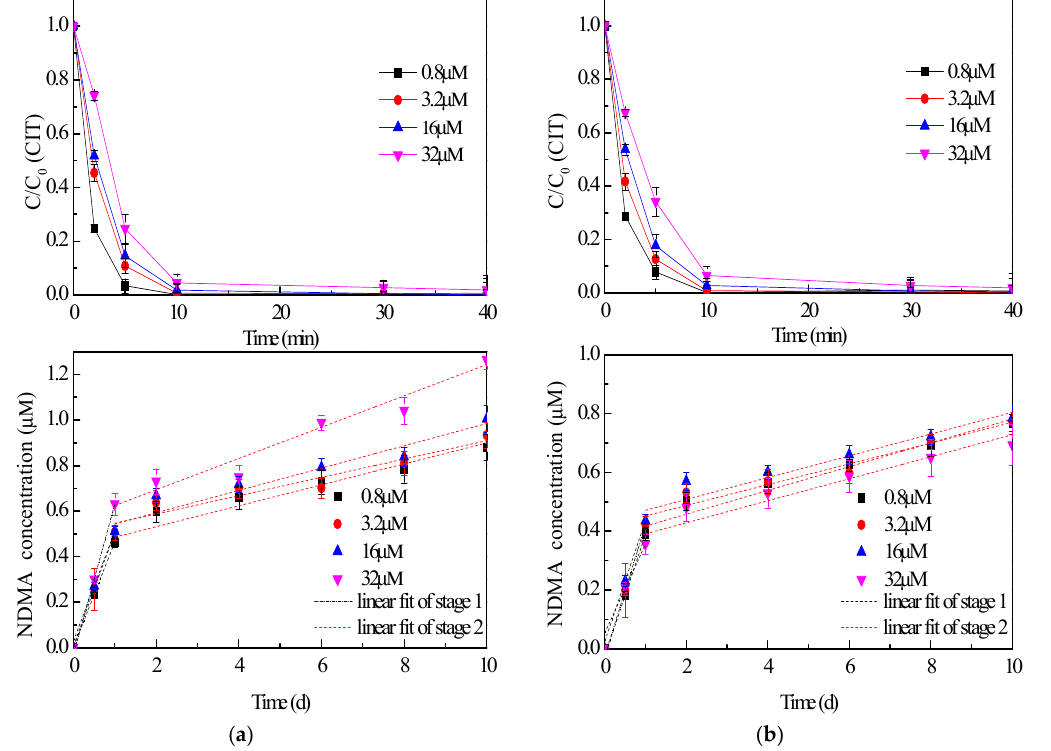
Figure 1. CIT removal and N -nitrosodimethylamine (NDMA) formation during CIT oxidation with NaOCl ( a ) and ClO 2 ( b ) at di ff erent initial concentrations of CIT ([NaOCl] = [ClO 2 ] = 1 mM, pH = 7.0) (Black dash lines represent linear fit of the first stage of NDMA generation, red dash lines represent linear fit of the second stage of NDMA generation).